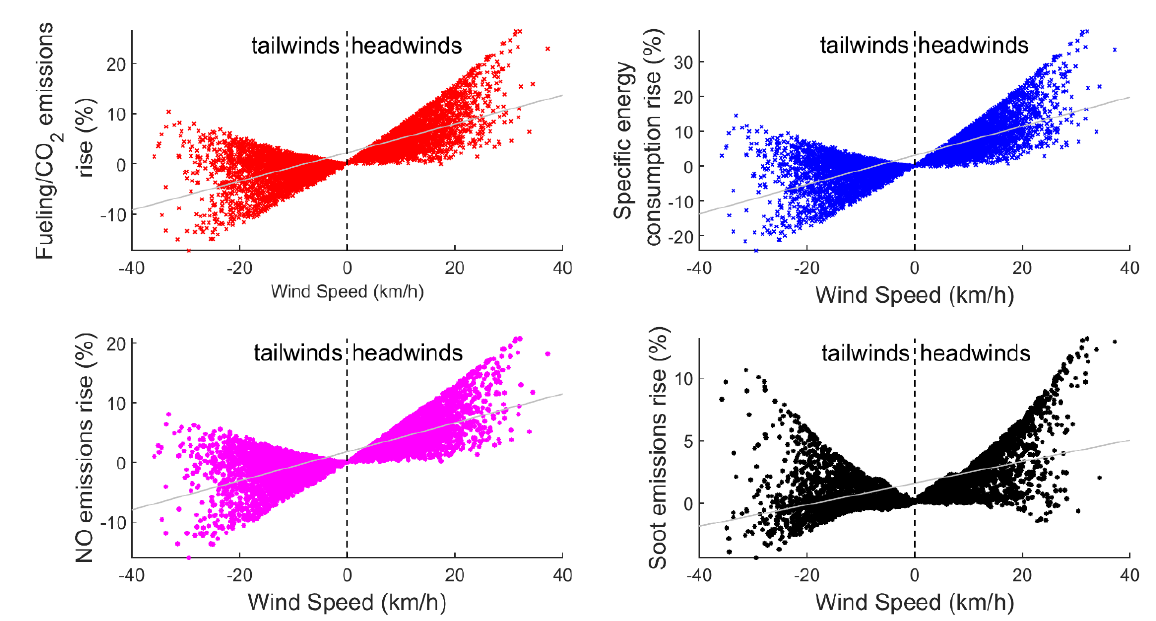
Figure 7. Percentage increase in consumption and emissions vs. wind speed for the extra-high phase of the WLTC.